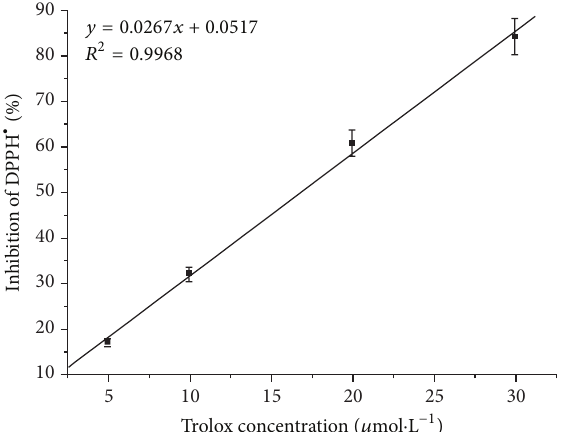
Figure 4: A representative calibration curve of inhibition DPPH ∙ by Trolox standards (5, 10, 20, 30 𝜇 mol ⋅ L −1 ). 𝑌 = 0.0267𝑥 + 0.0517 and 𝑅 2 = 0.9968